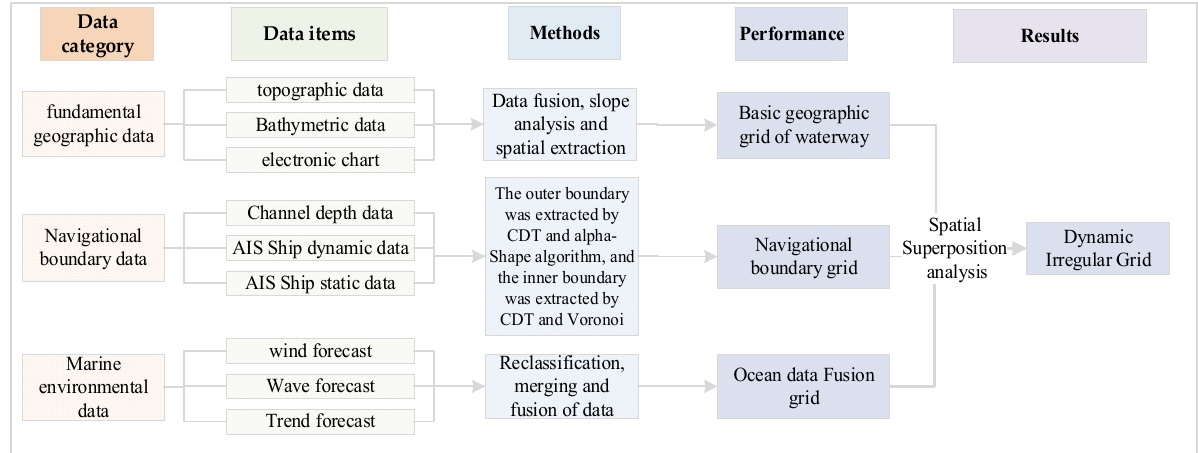
Figure 2. The flow of dynamic irregular grid division.